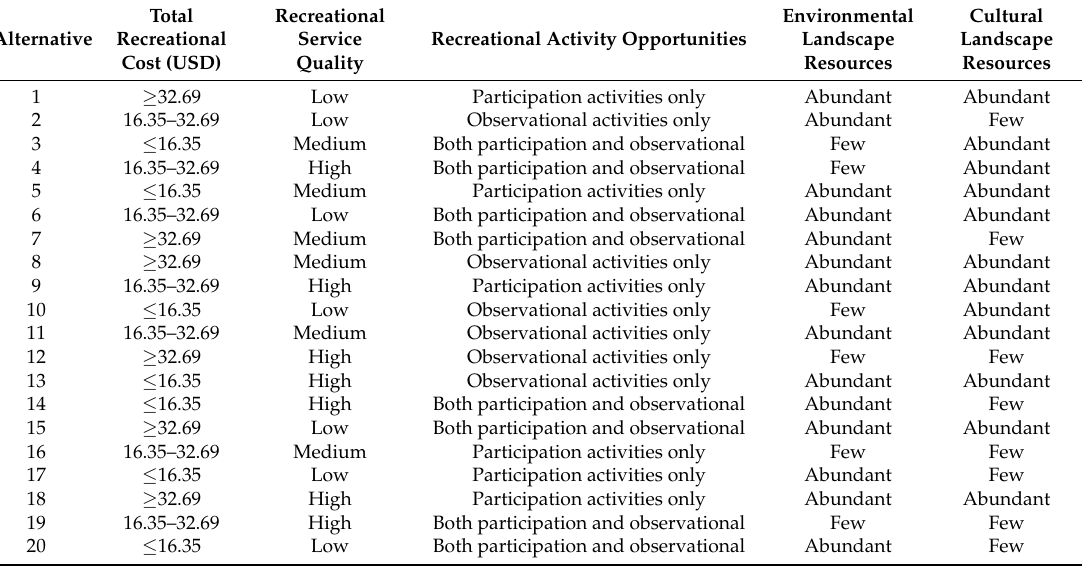
Table 2. Attribute levels of the 20 alternatives of visits to Calligraphy